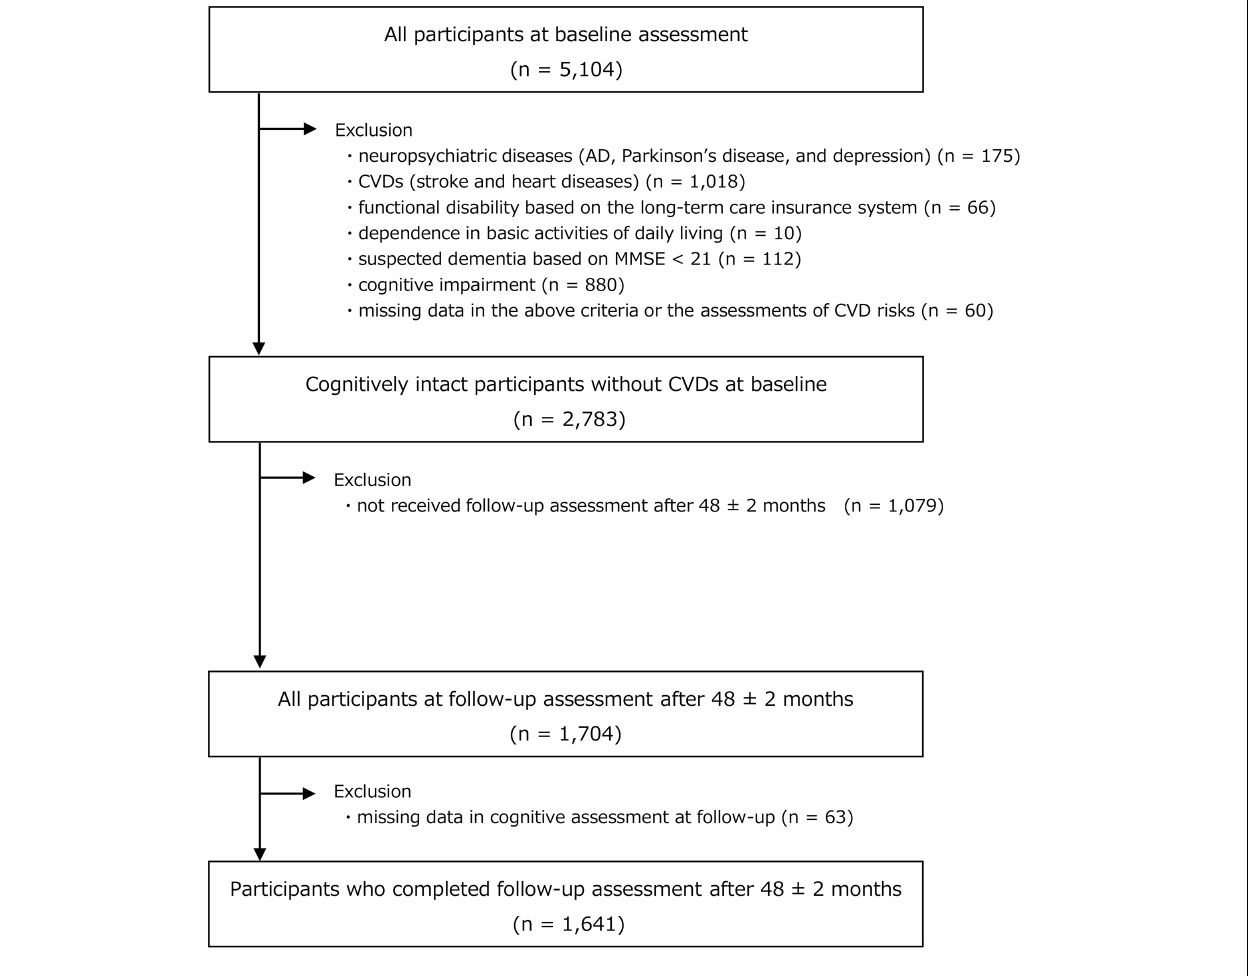
FIGURE 1 | Flowchart of participant recruitment and